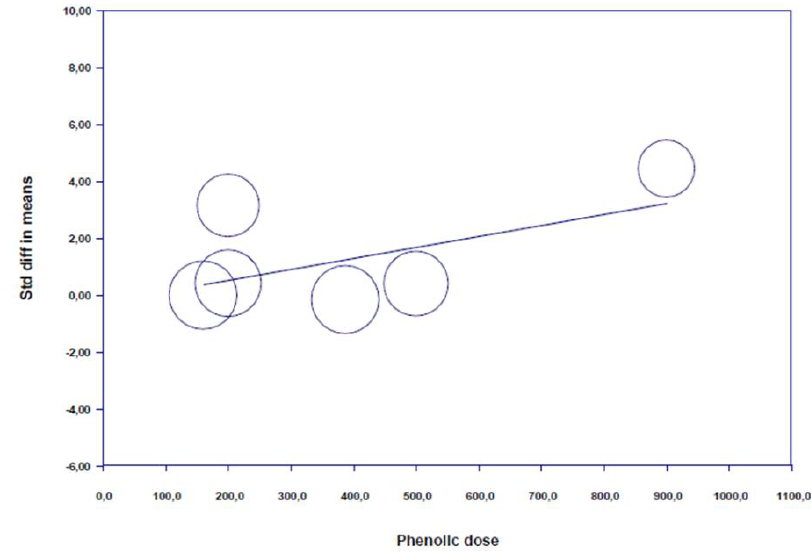
Figure 6. Scatter plot of regression analysis showing the influence of polyphenols supplementation by phenolic dose.